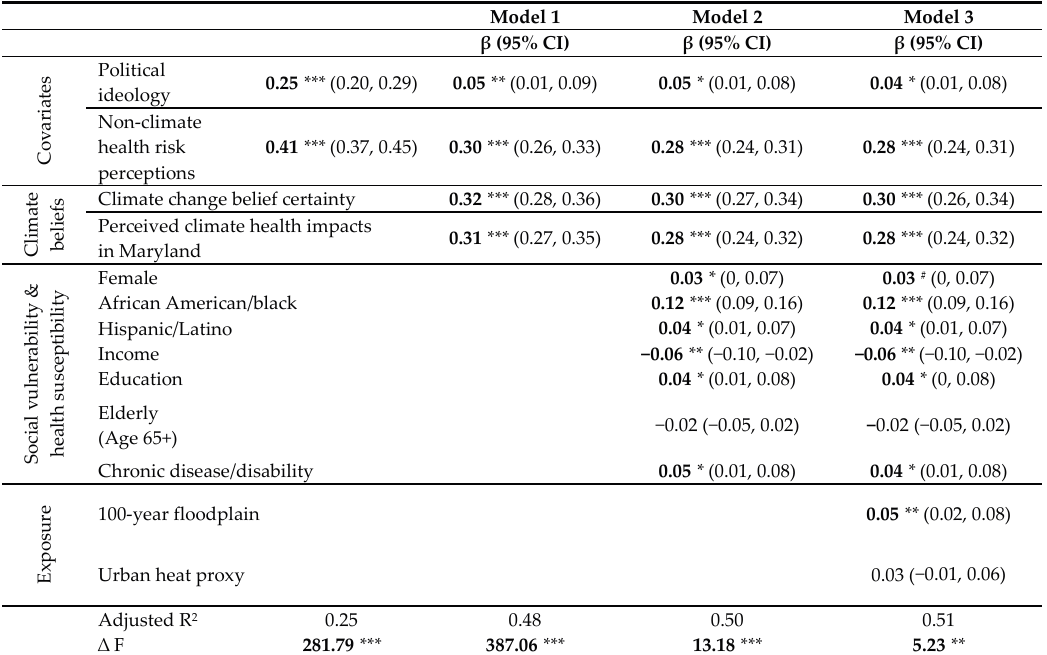
Table 3. Predictors of perceived vulnerability to climate change health